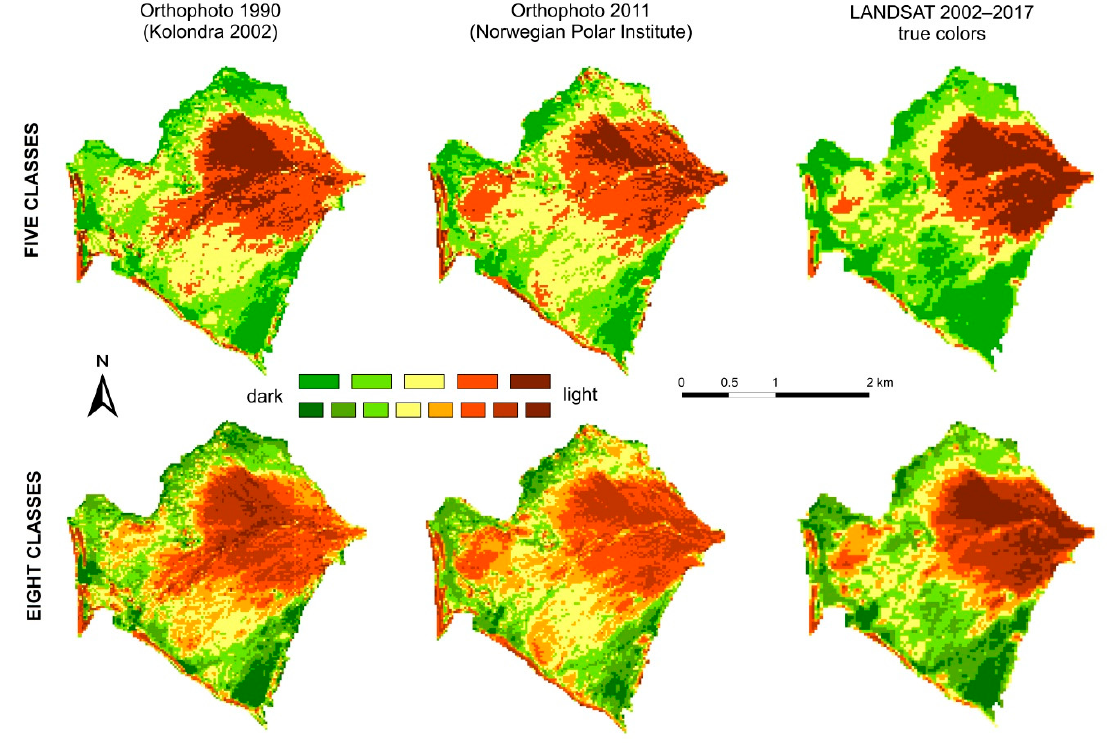
Figure 4. Results of the Elveflya outwash fan photointerpretation.